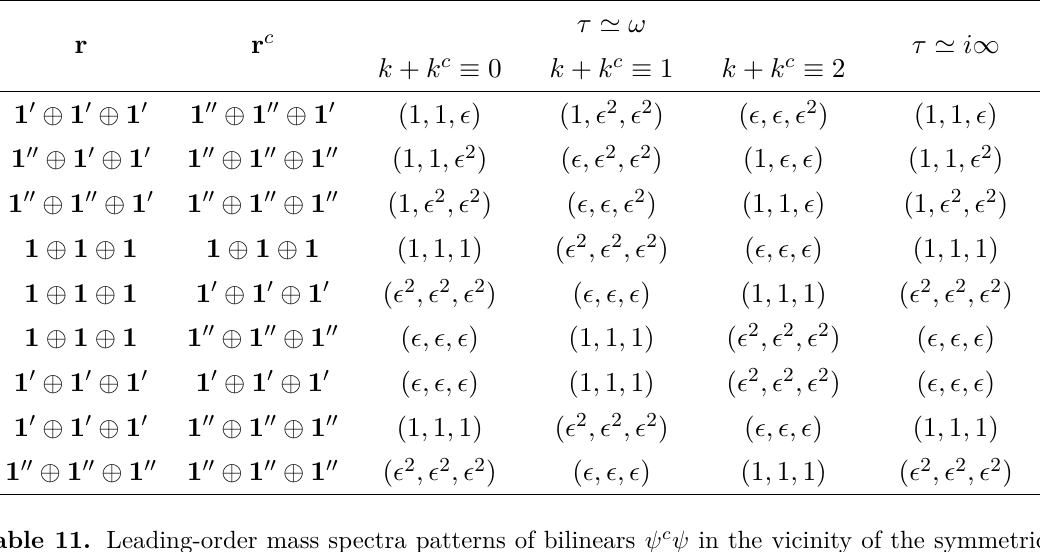
Table 11. Leading-order mass spectra patterns of bilinears ψ c ψ in the vicinity of the symmetric points ω and i ∞ , for 3d multiplets ψ ∼ ( r , k ) and ψ c ∼ ( r c , k c ) of the finite modular group Γ 0 = T 0 . Spectra are insensitive to transposition, i.e. to the exchange ψ ↔ ψ c . Congruence ’ A 0 3 4 relations for k + k c are modulo